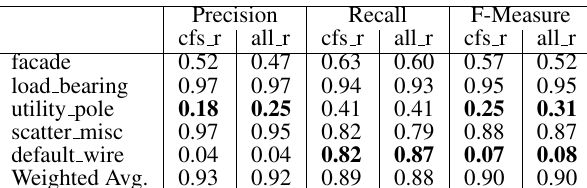
Table 3. Performance measures of the best performing configurations: Ball-shaped neighbourhoods,